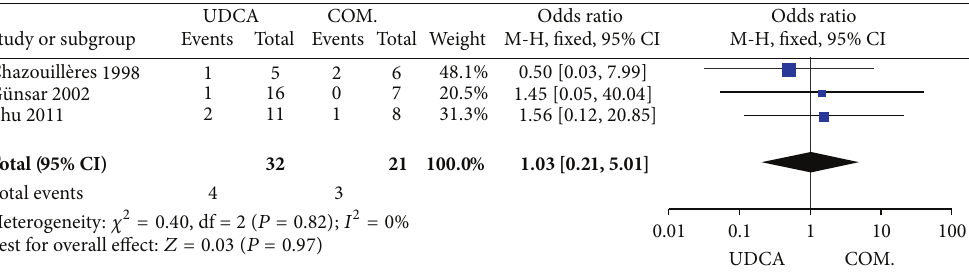
Figure 8: Adverse events in patients treated with monotherapy versus combination therapy for PBC-AIH.